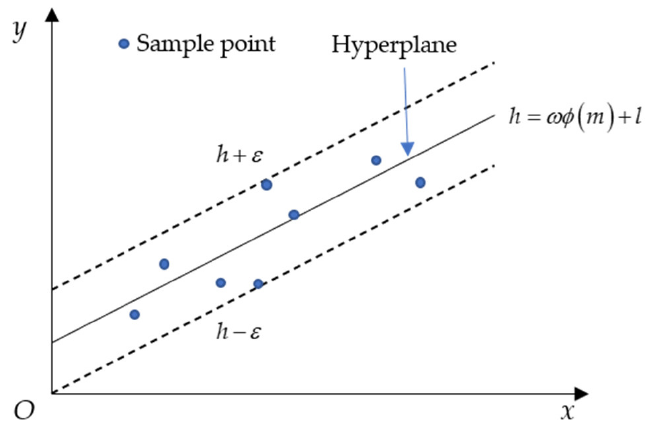
Figure 1. Hyperplane diagram.